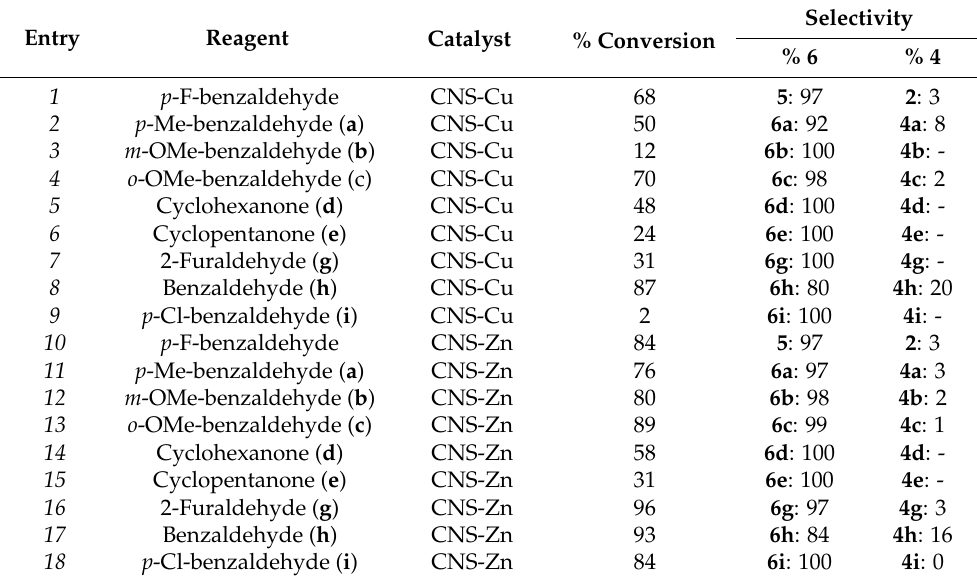
Table 11. Results of the reusability tests conducted with CNS-Cu a